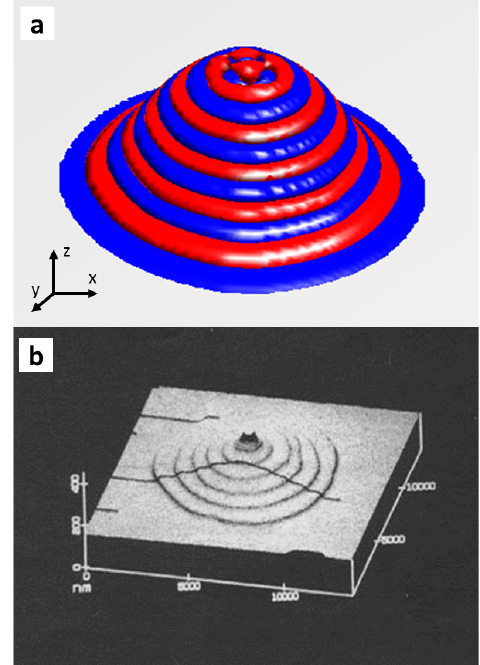
Figure 7: (a) Nano-droplet structures obtained for a bulk phase copolymer of lamellae. (b)AFM